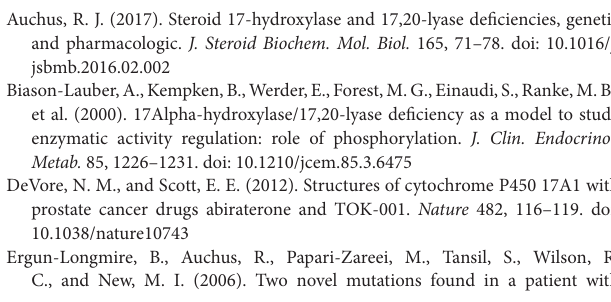
FigURe s1 | Karyotype of the proband: Normal 46,XX. FigURe s2 | (A,B) Quality scores across all bases: An average base quality of 40 in FASTQ fles and a coverage of 99.59% in targeted regions. FigURe s3 | Conservative analysis in different vertebrates: Phe435 is conserved among the P450c17s from different vertebrates (Pan troglodytes, Felis catus, Mus musculus, Gallus gallus, Danio rerio, and Xenopus tropicalis). FigURe s4 | Quantitative PCR results: There are no CYP17A1 gene differences in mRNA levels among